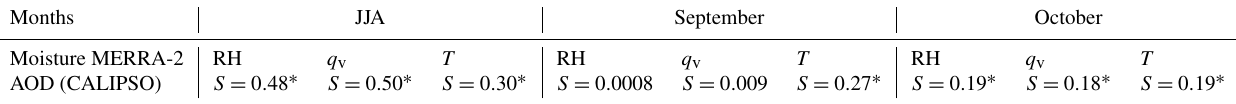
Table 3. Spearman correlation coefficient ( S ) between the AOD (Column Optical Depth Tropospheric Aerosols at 532nm from CALIPSO’s Aerosol Profile Data product) and average moisture (RH and q v ) at the altitude range of aerosol layers in the free troposphere (2–7km) and between AOD and temperature ( T ) at the altitude range of the boundary layer top inversions (1.5–2km ). Atmospheric profiles selected are those where there is aerosol extinction only between 2 and 7km. Values are calculated during a 4-year period (2007–2010) for June–July– August (JJA), September, and October. Correlation values marked with an asterisk ( ∗ ) are significant at the 95% level. Months